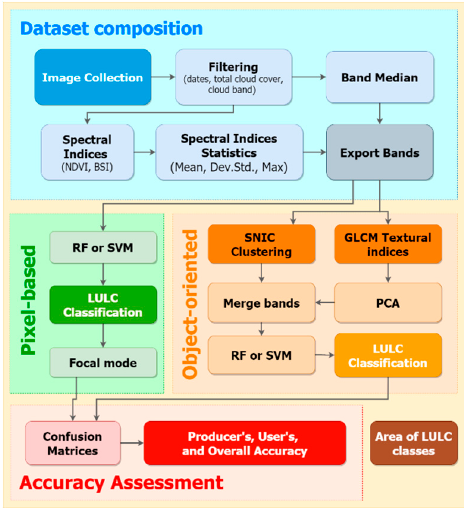
Figure 2. The methodological workflow implemented in Google Earth Engine (GEE).